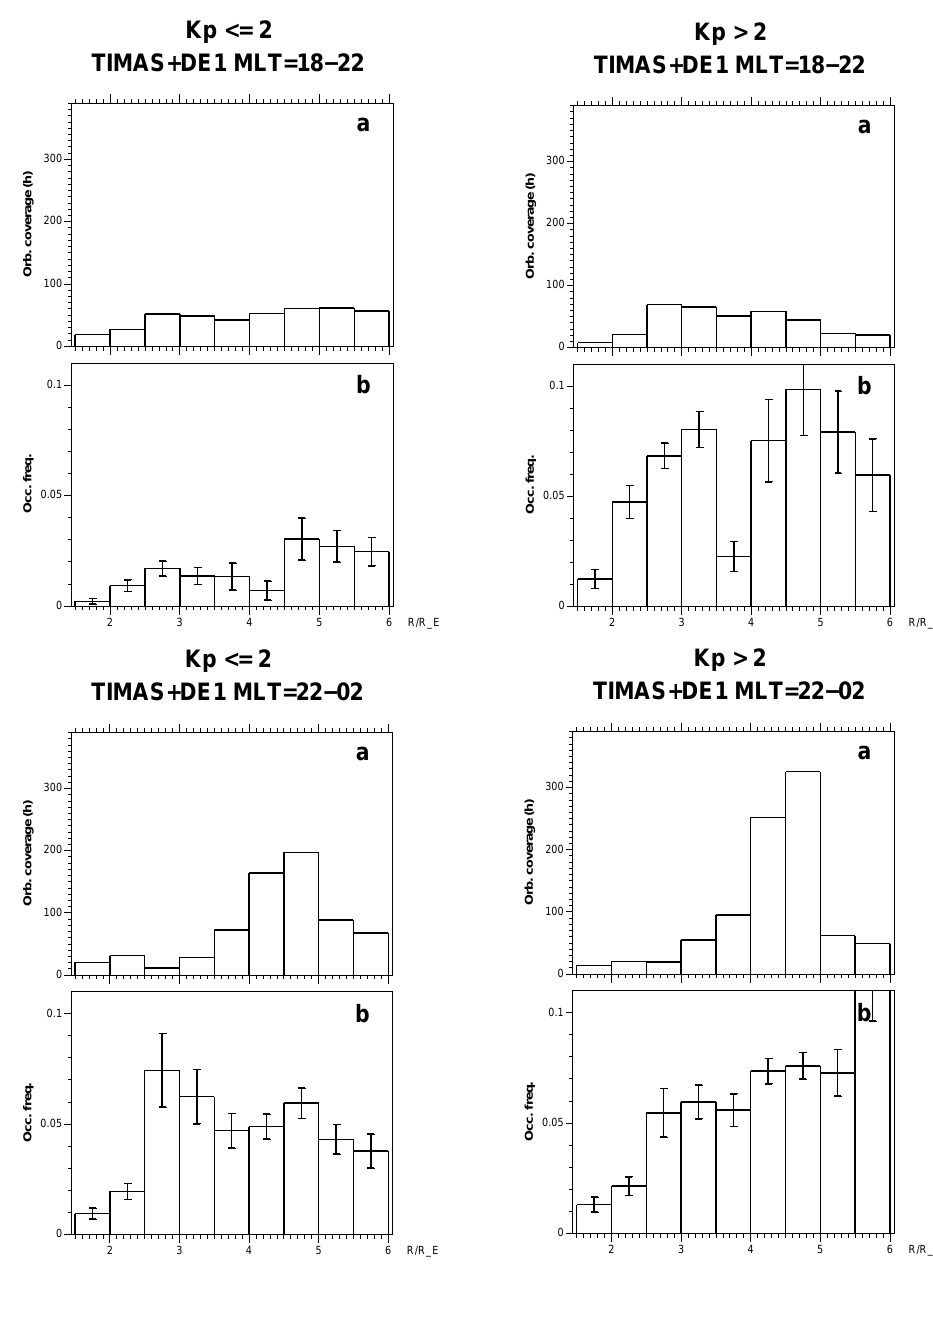
Fig. 3. Ion beam occurrence frequency in 18–22 (top) and 22–02 (bottom) MLT range from combined Polar/TIMAS and DE-1/EICS data when the ionospheric footpoint is in darkness: (a) orbital coverage in hours in each bin, (b) occurrence frequency of ion beams with energy more than 0.5keV. Left plots are for K p ≤ 2 and right plots for K p > 2. the closed potential structures (Olsson et al., 2004). In Sect.